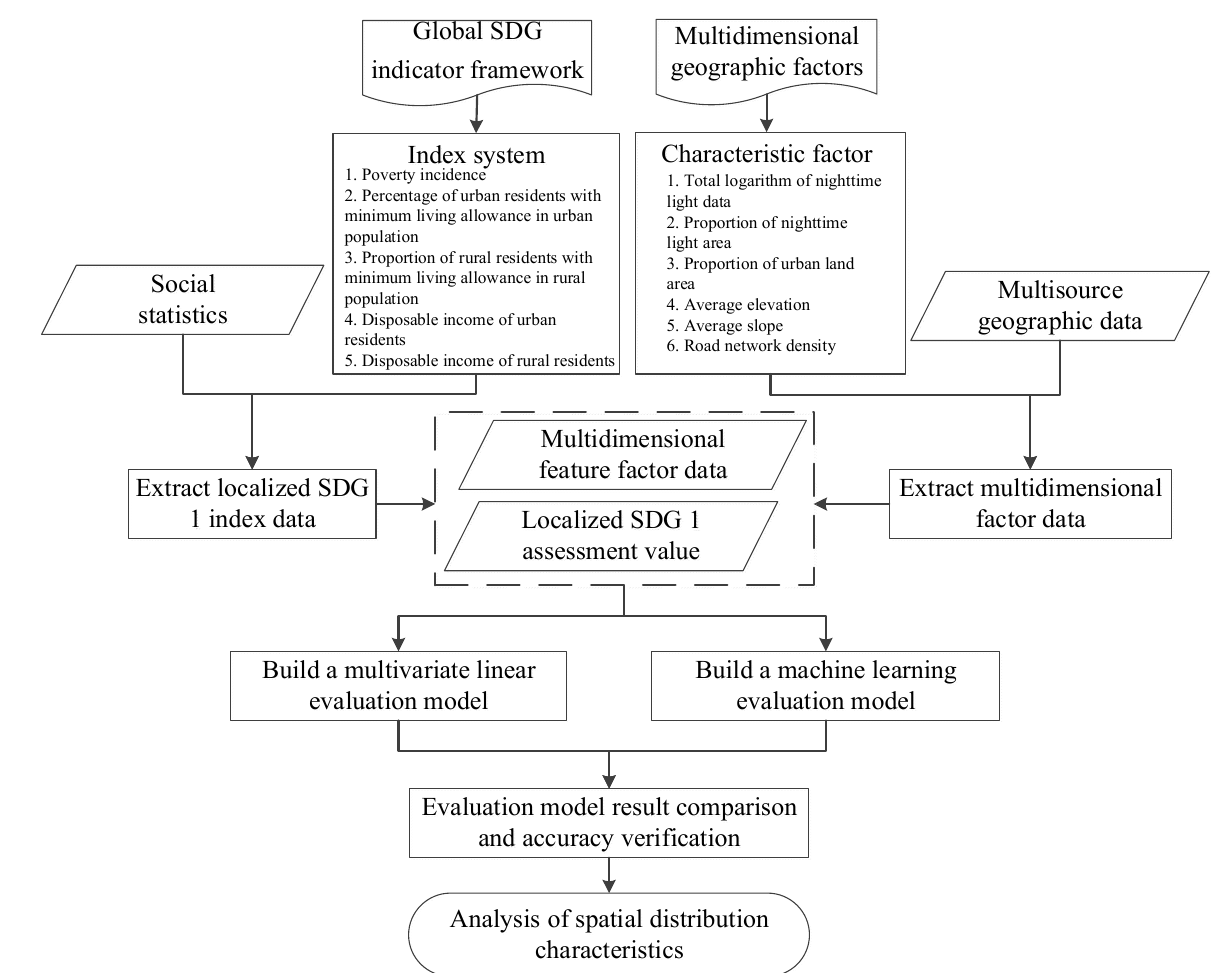
Figure 2. Flow chart for the evaluation and analysis of poverty-stricken counties in Hunan Province. Among the indicators included in the system, localized, SDG 1 indicator 1 corresponds to indicators 1 and 2 in the global SDG framework, and localized indicators 2 and 3 correspond to indicators 3 and 4 in the global SDG 1 framework. Due to the nature of the SDG 1 indicators in the global SDG framework, it is difficult to obtain data relevant to indicators 5, 6, and 7 for districts and counties in Hunan Province in 2014, 2016 and 2018. Therefore, the disposable incomes of urban and rural residents are added to reflect their living standards. The localized SDG 1 indicators for the districts and counties included in this article are based on the global SDG indicator framework and the completeness of Hunan Province’s district and county data. Compared with the global SDG indicators, the localized indicators more comprehensively reflect the level of regional socioeconomic development and better reflect the SDGs focused on eliminating all forms of poverty. Local indicator data are also more readily